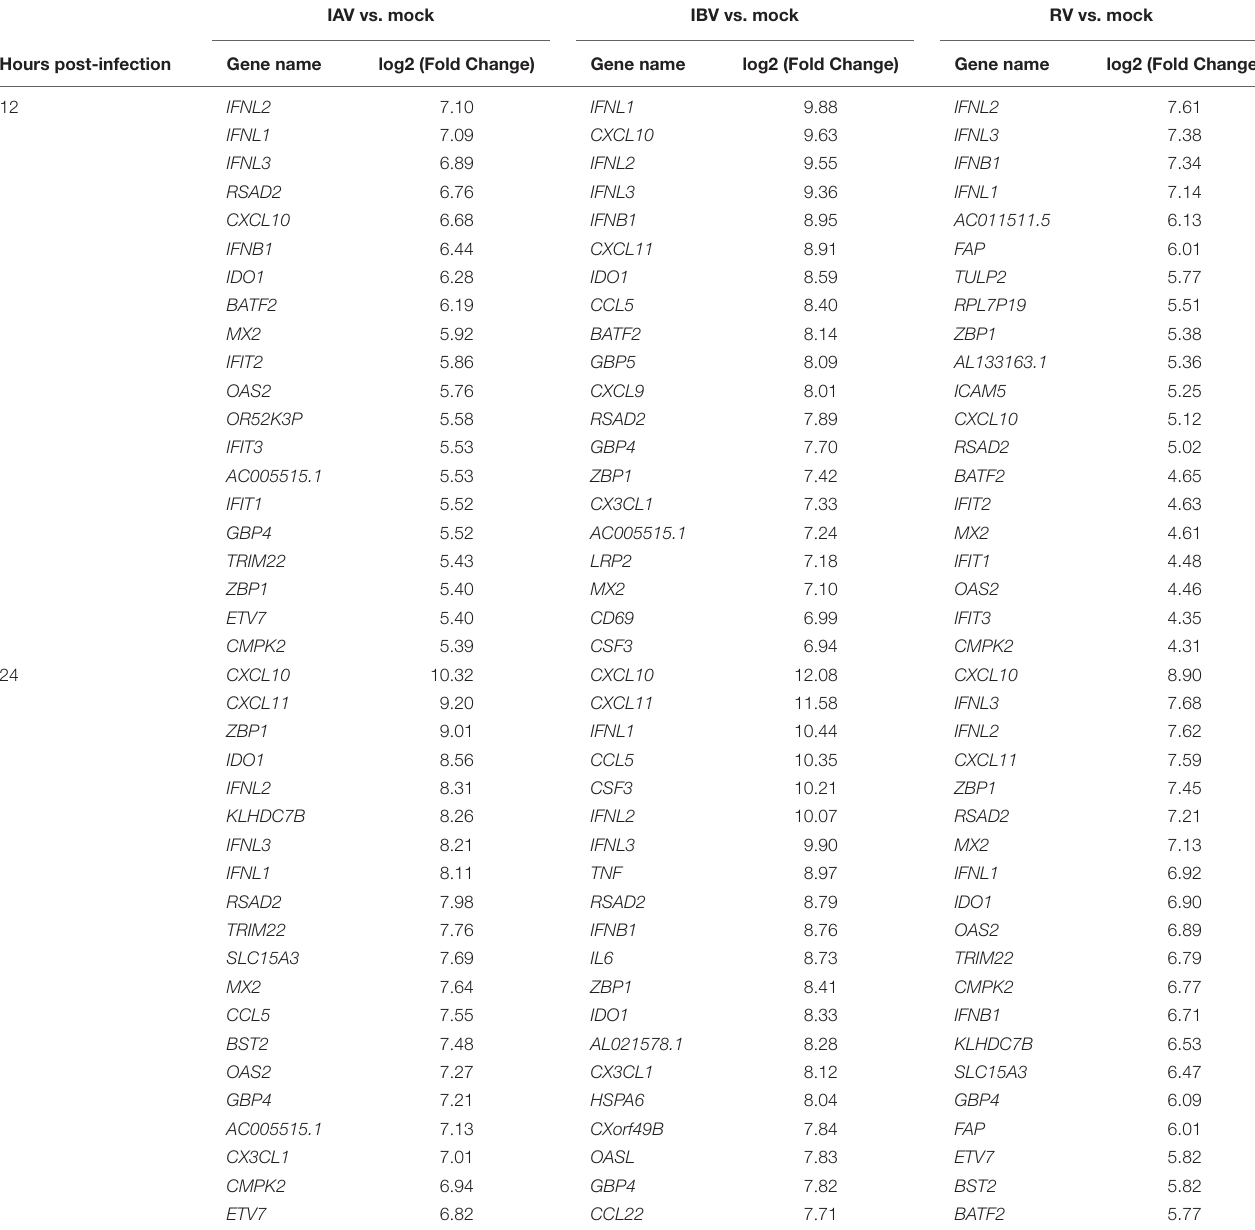
TABLE 1 | Top 20 upregulated DEGs when compared with mock-infected cells. IAV vs. mock IBV vs. mock RV vs.